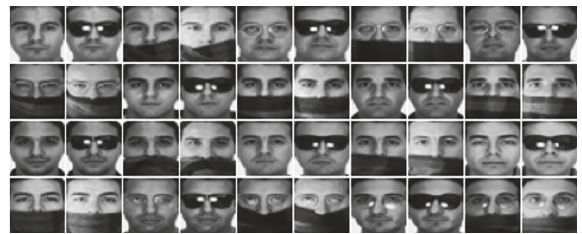
Figure 3: Examples of the AR database.